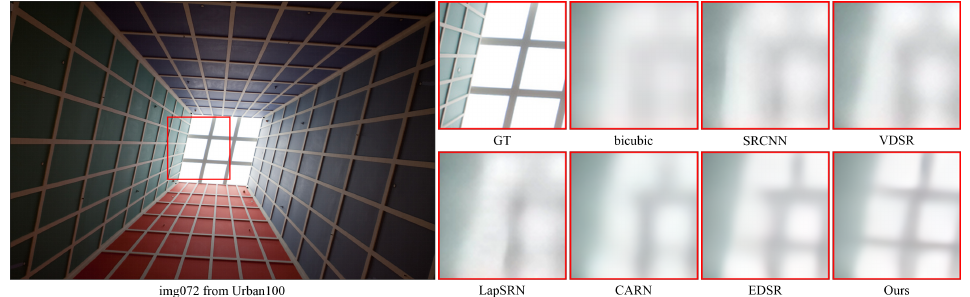
Figure 9. Qualitative comparison of image reconstruction results for × 32 magnification in the Urban100